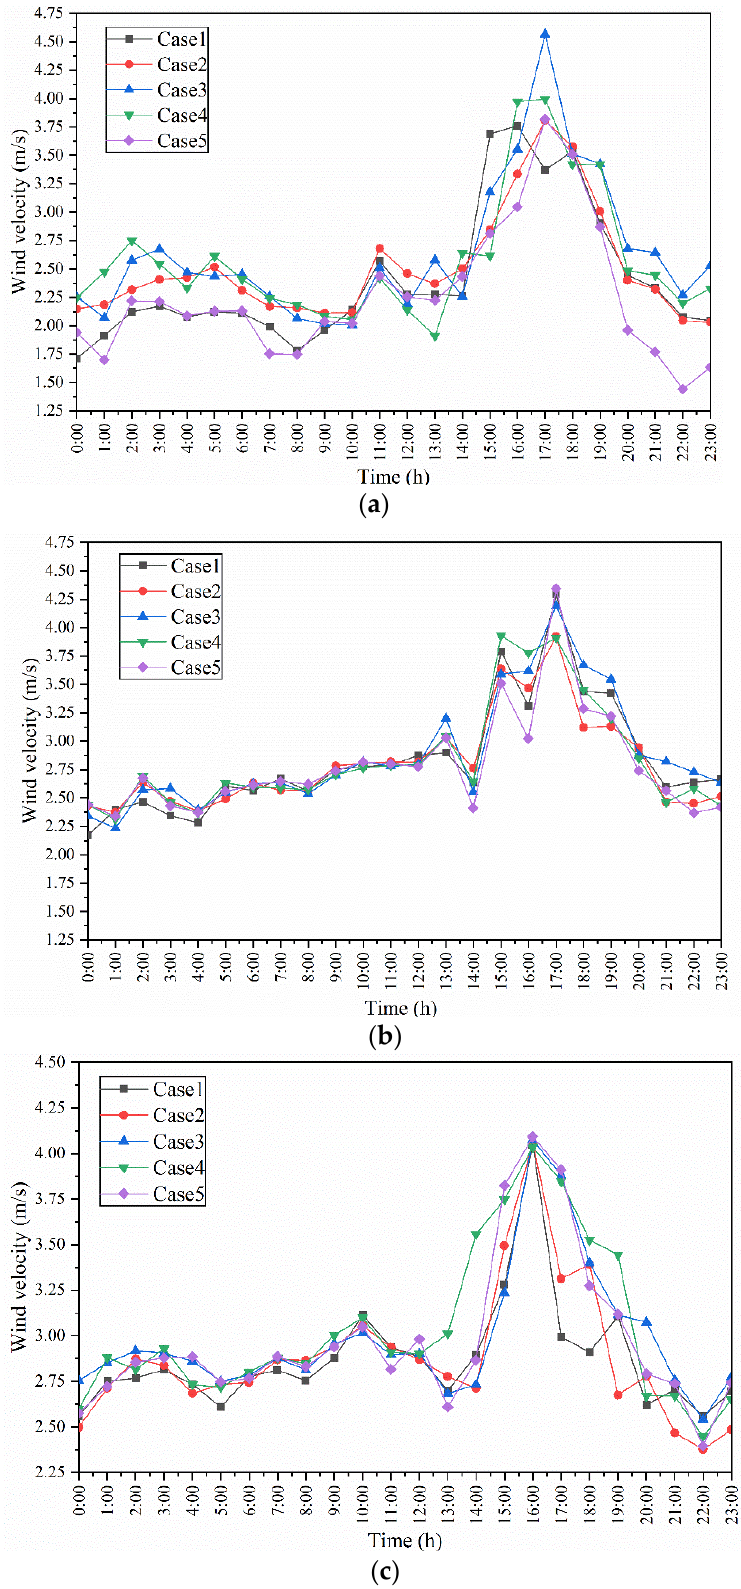
Figure 8. Daily wind velocity variation in the ( a ) business, ( b ) residential, and ( c ) industrial areas. In the residential area, the greening area has a limited impact on regional wind ve- locity. The minimum wind velocity is about 2.1 m/s at 0:00 when the greening rate is 20%, and the maximum wind velocity is about 4.3 m/s at 17:00 when the greening rate is 40%. At the duration of 0:00–15:00, greening land has little impact on regional wind velocity. In the industrial area, the fluctuation range of wind velocity is larger than that of the residential area but smaller than that of the business area. After 11:00, the wind velocity increases rapidly and falls rapidly after reaching its peak at 14:00, and it reaches its valley at 22:00, with the maximum value being about 4.1 m/s and the minimum value being about 1.3 m/s. 3.4 Limitations of this Study There are some limitations to this study. Theoretically, the urban microclimate is a multifactor system that is not only affected by greening areas and water bodies, and the exact contribution of these factors to microclimate change has not been established. Sec- ondly, the distribution of greening areas and water bodies is at the horizontal profile, while the vertical geometry of cities (building façade, height, and agglomeration) has a considerable impact on the evolution of the urban microclimate. In addition, in the UCM model used in this study, the anthropogenic heat is not considered due to its large statis- tics and different regions.